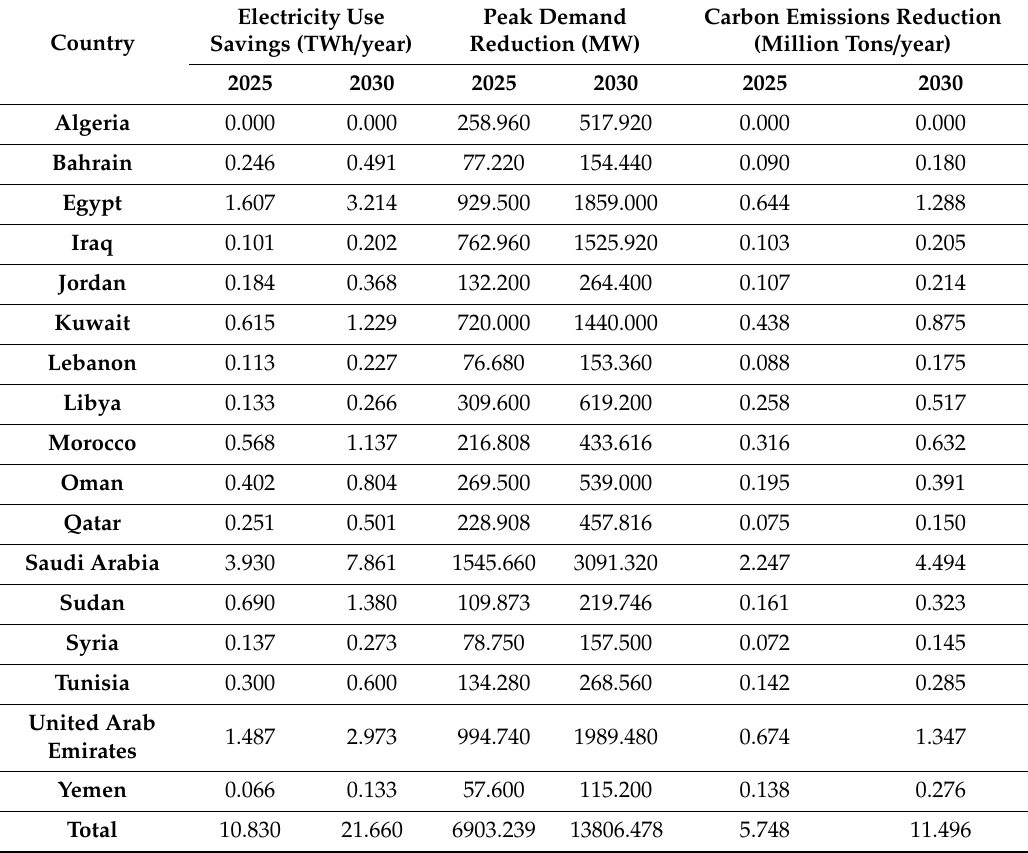
Table 17. Potential annual benefits attributed to using integrated control LED lighting units in commercial and services buildings in the Arab